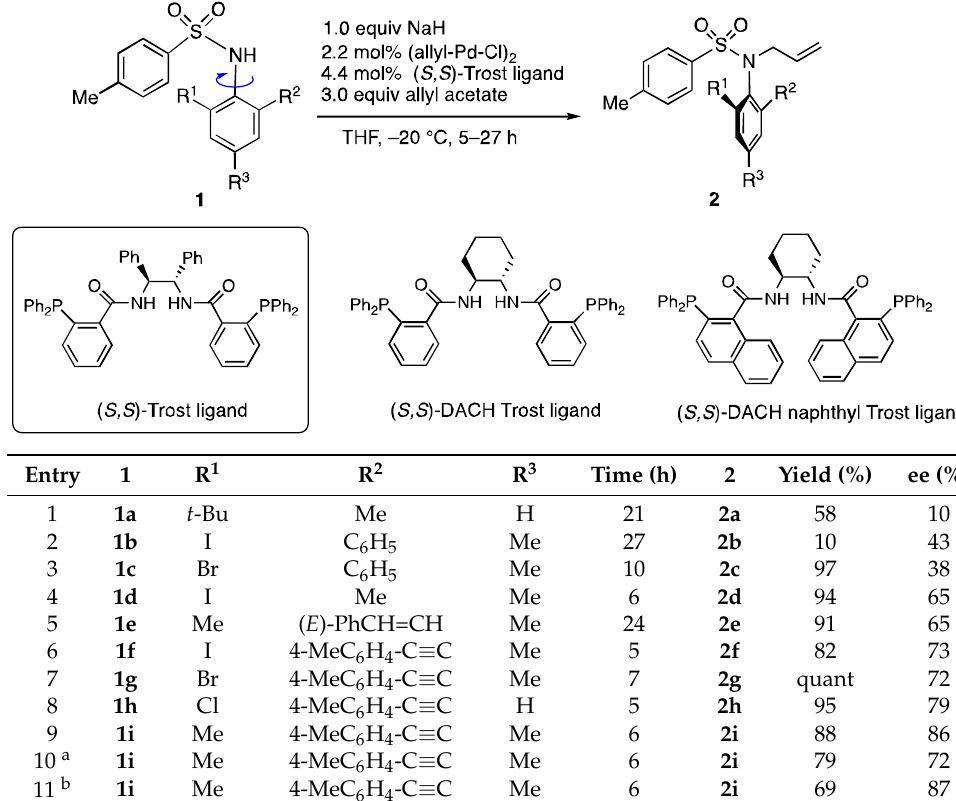
Table 1. Enantioselective N -allylation of secondary sulfonamides 1 bearing various 2,6-disubstituted-phenyl groups.